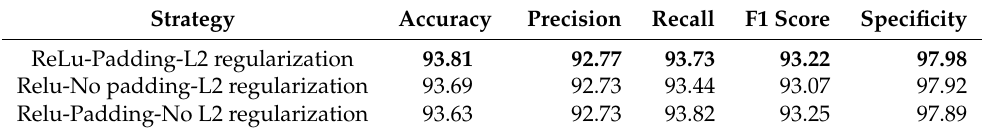
Table 5. Metrics for different CNN architectures without data augmentation. The best metric results are highlighted in boldface